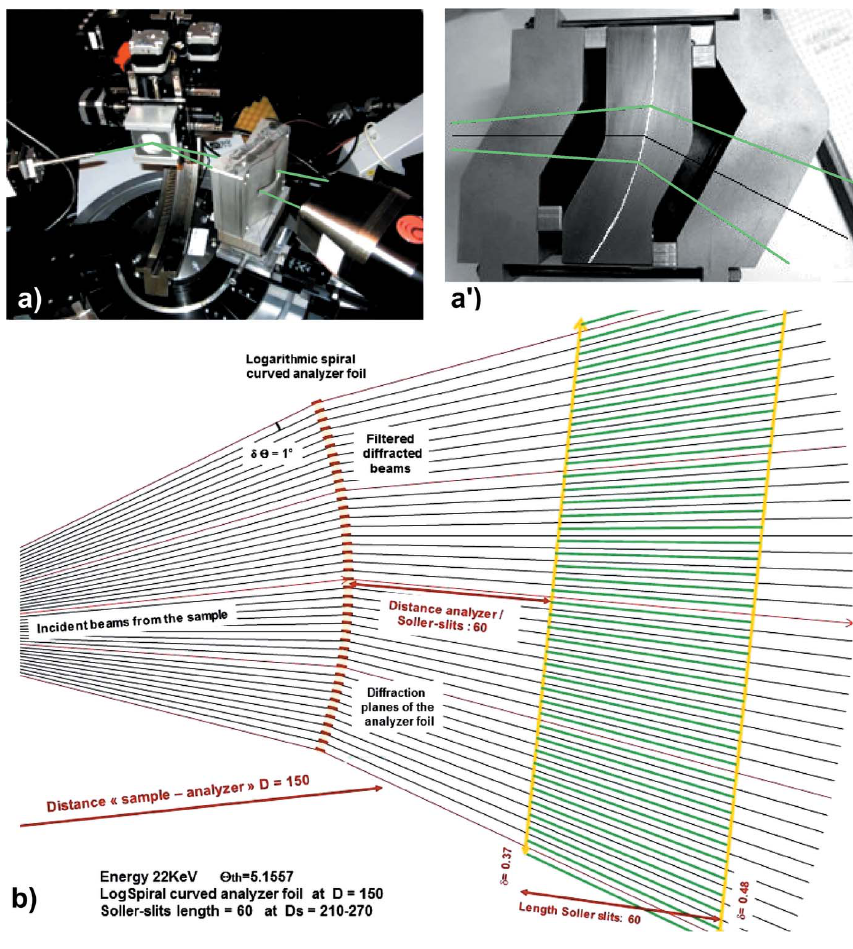
Figure 6 Compact MAD analyser block with a thin LogSpiral curved analyser crystal perpendicular to its Si(111) diffraction planes and working at a distance D = 150 mm in Laue transmission mode with X-rays having the Cu K (cid:2) 1 energy. ( a ) Photograph of this setup during a laboratory experiment (beam paths are in green). ( a 0 ) Enlarged photograph of such a compact MAD block working in Laue transmission mode (beam paths are in green). ( b ) Schematic representation of beam paths filtered by this curved MAD filter and then cleaned/separated by a Soller collimator having long blades (60 mm) located and optimized for the distance D s = 210–270